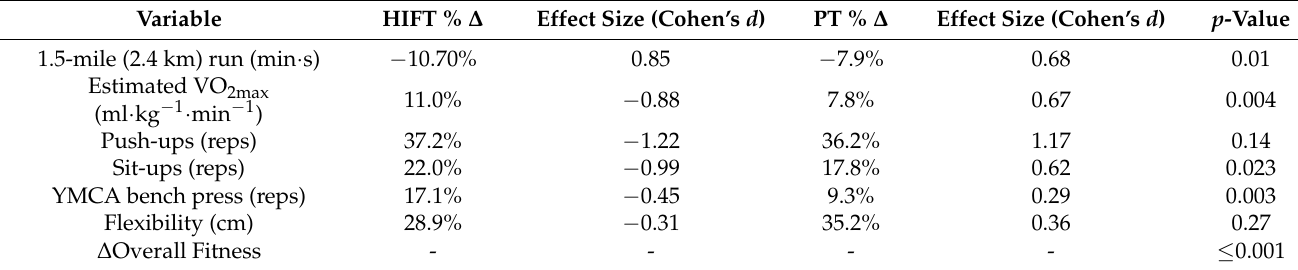
Table 6. Changes in Fitness during HIFT and Traditional PT